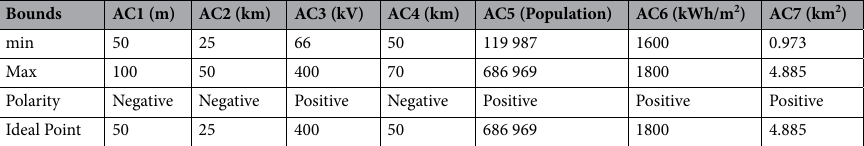
Table 3. The SPOTIS approach.